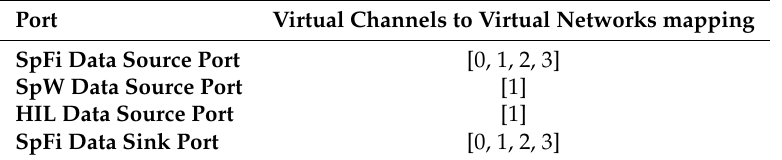
Table 3. Routing Switch Virtual